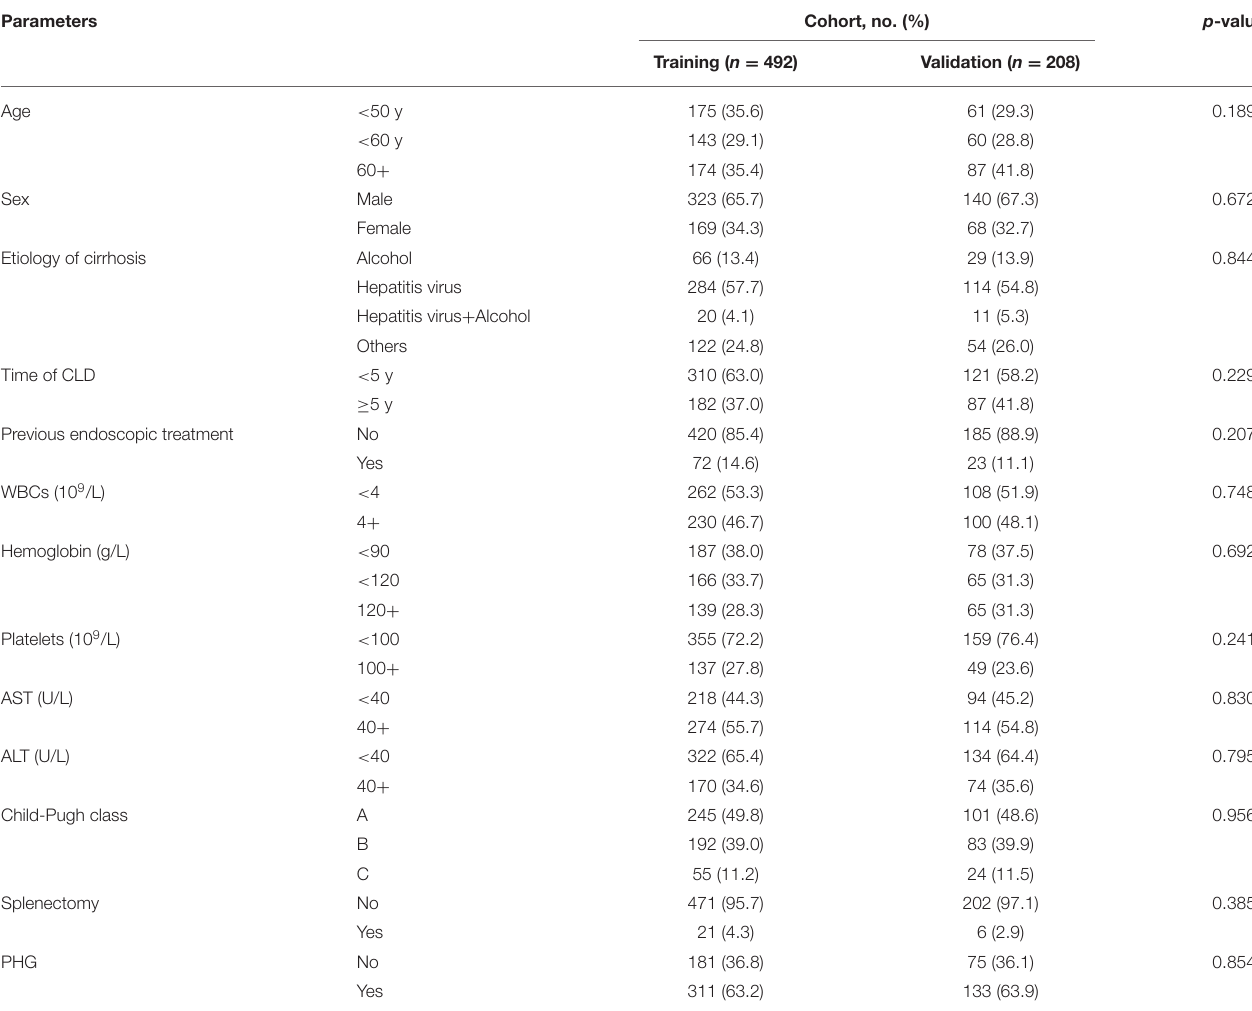
TABLE 4 | Baseline characteristics of the training and validation cohorts.